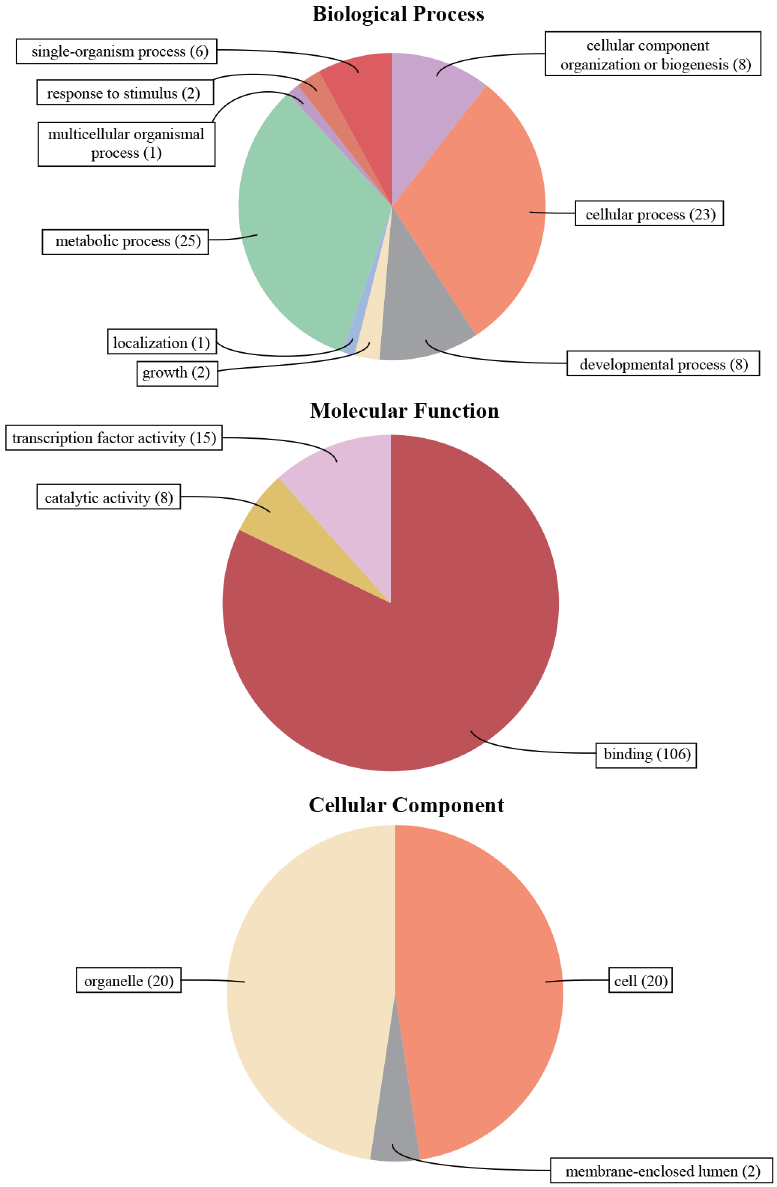
Fig 4. Gene Ontology (GO) results for Populus C2HC2-ZF proteins. GO analysis of 109 C2HC2-ZFP sequences predicted for their involvement in biological processes, molecular functions and cellular components. For the results presented as detailed bar diagrams, see S10